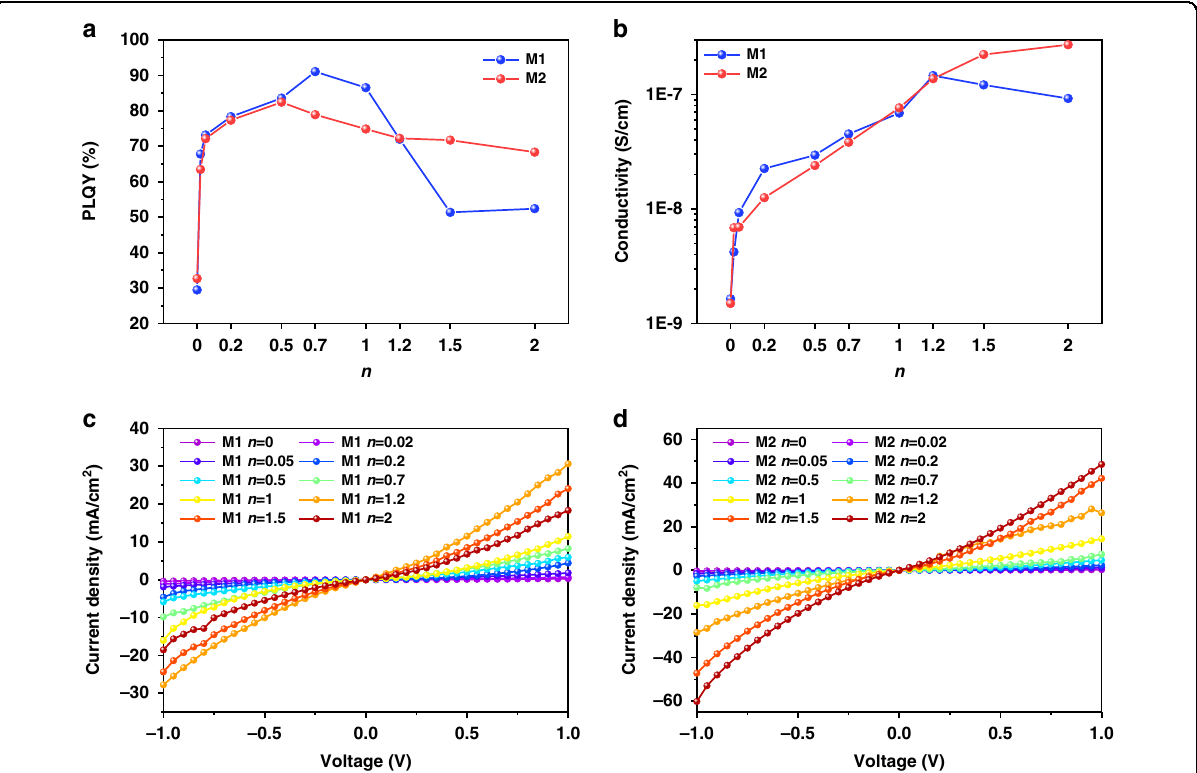
Fig. 5 The improvement of blending fi lms in optical and electrical properties. a PLQY of blending fi lms. b Conductivity of blending fi lms. c J - V curves of M1 blending fi lms. d J - V curves of M2 blending fi